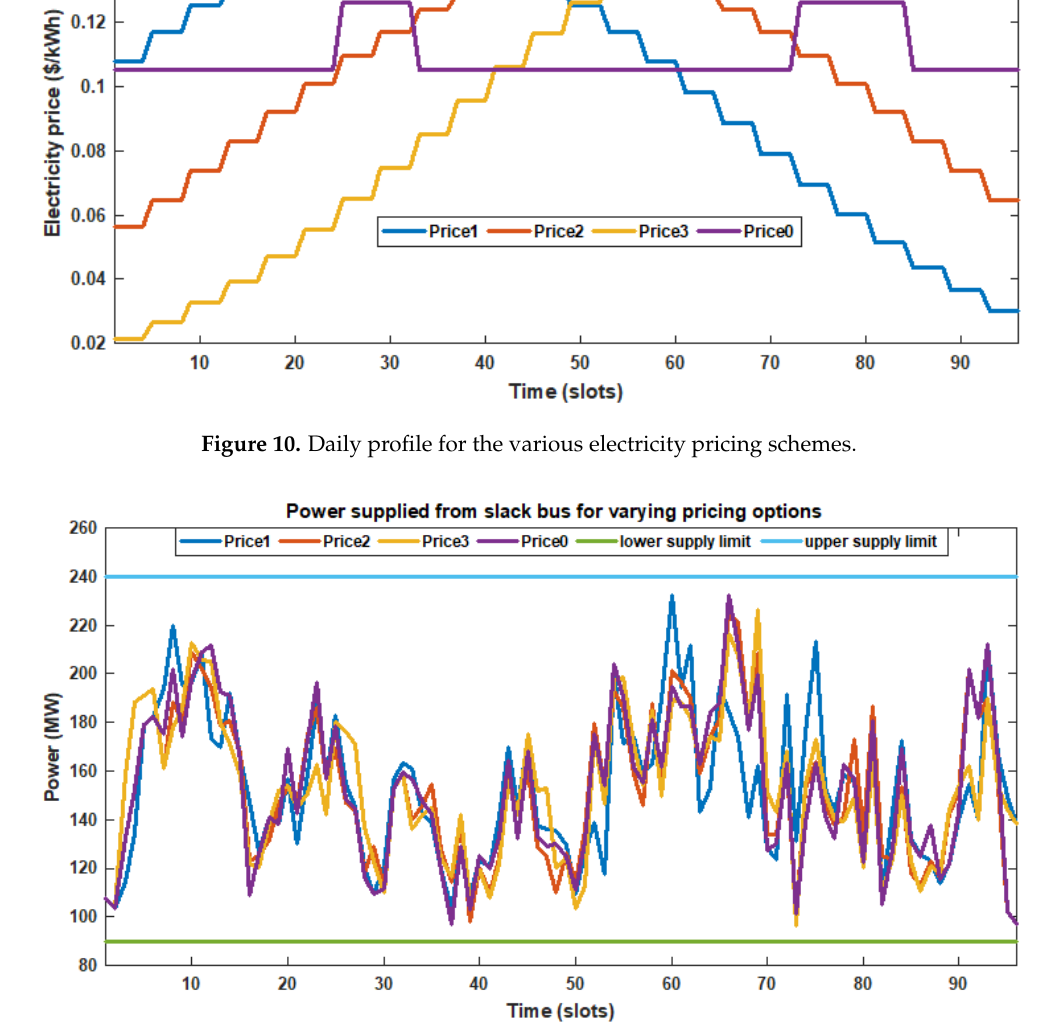
Figure 11. Daily profile for power supplied from slack bus (bus